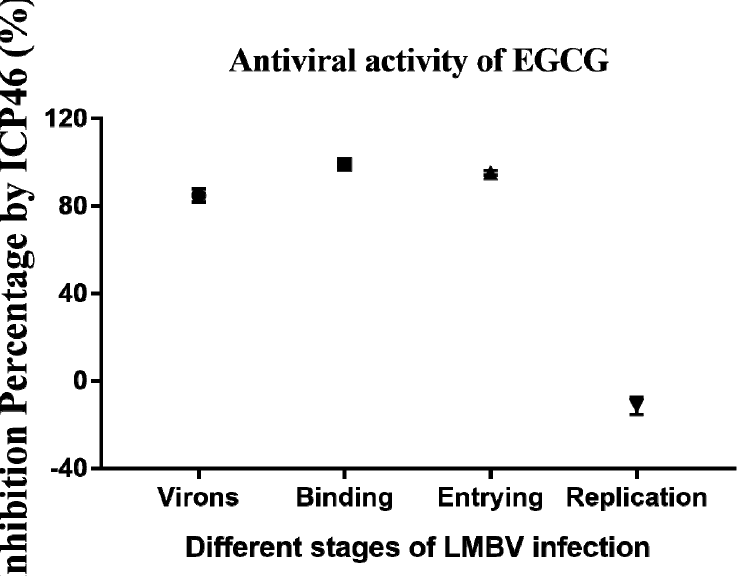
Figure 6. Inhibitory percentage of EGCG on different stages of LMBV infection. The inhibitory effects of EGCG on LMBV infection mainly acted on LMBV particles, the binding of LMBV to host cell membranes (test 1), and invasion of cells (test 2), and no inhibition was found in the replication phase (test 3). The inhibitory rates of virons, binding, entrying, replication stage were 84.89%, 98.99%, 95.23%, and − 11.38%, respectively.